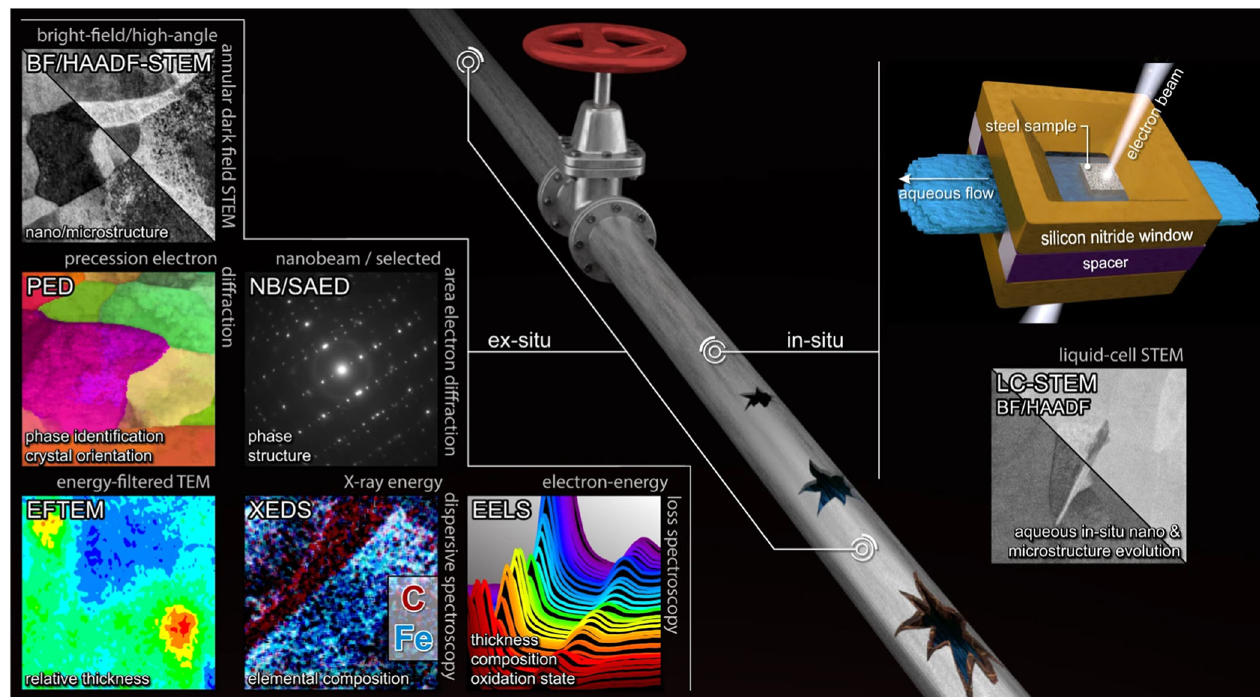
Fig. 1 A representative localized corrosion research work fl ow. A series of in situ and ex situ new experimental methodologies at the micro- scale and/or nano-scale 15